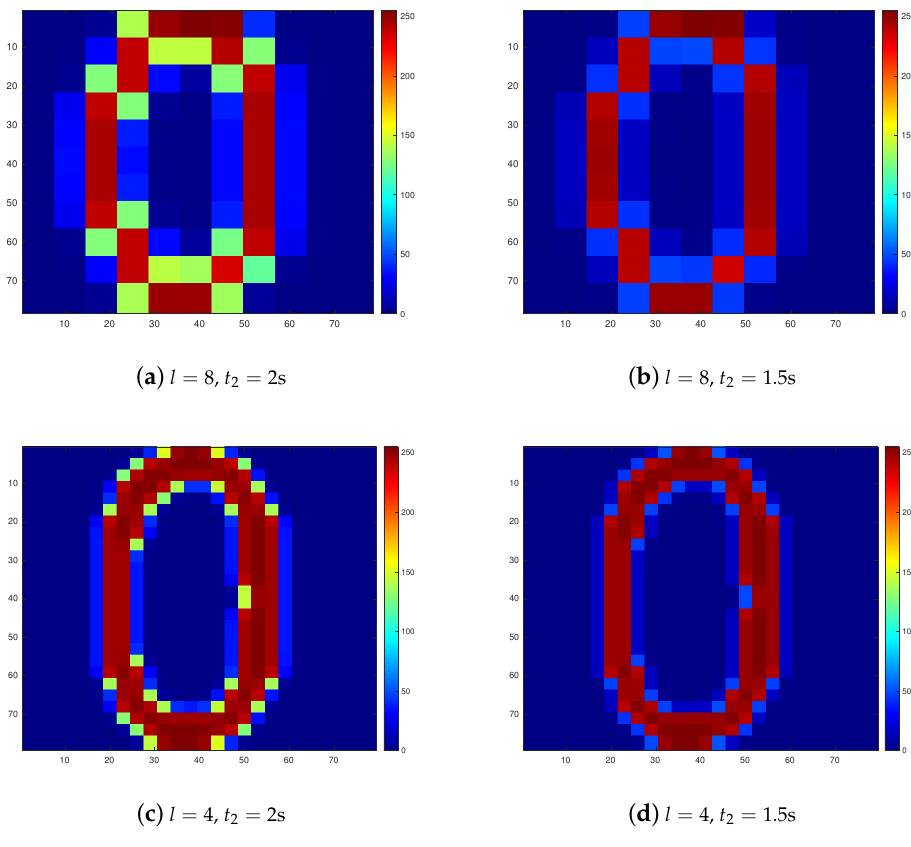
Figure 13. Calcium patterns of astrocytes with different astrocytic coverage areas and time intervals between training and testing. Here, we use f 0 = 58 and noise level equal to 0.2 as an